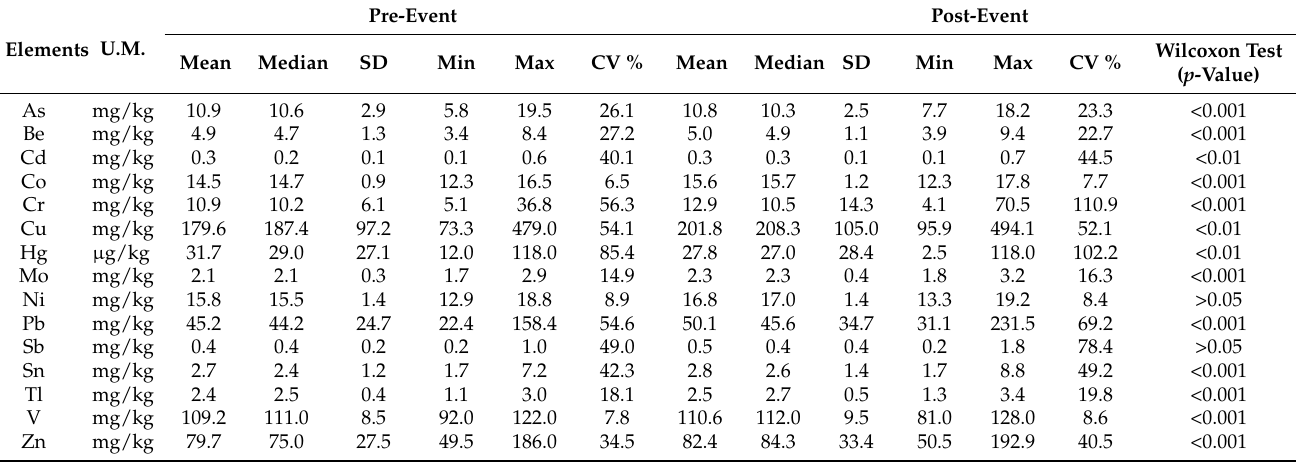
Table 2. Vesuvian area. Descriptive statistics of the PTEs in the soil before and after the fire event. p -values ranges: p > 0.05 not significant; p < 0.05 significant; p < 0.01 very significant; and p < 0.001 highly